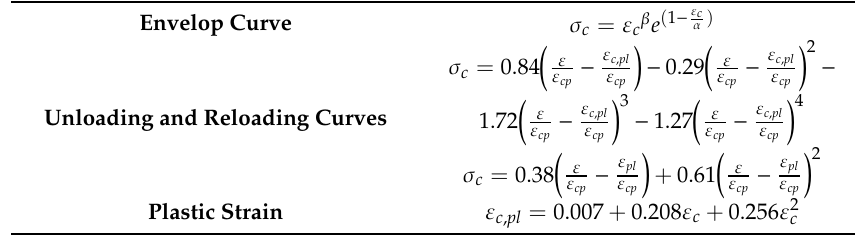
Table 1. Constitutive model for masonry under cyclic compression: Subramaniam and Sinha [25].